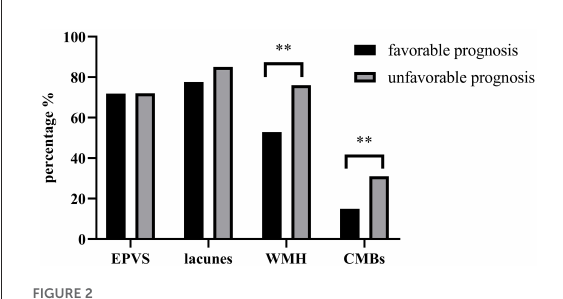
FIGURE2 Comparison of EPVS, lacunes, WMH and CMBs between patients with and without a favorable prognosis. ** P < 0.01.